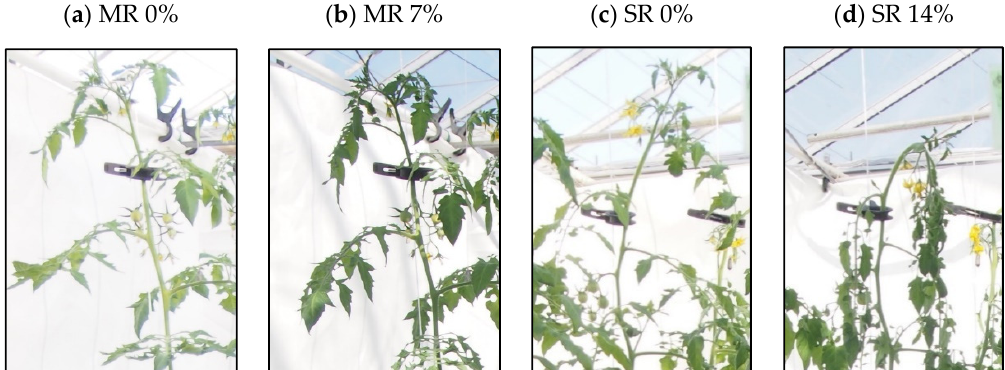
Figure 1. Digital color images of tomato plants captured from the side at three wilting ratios. ( a ) Plant subjected to MR without wilting in the early morning. ( b ) Plant subjected to MR when W was 7%. ( c ) Plant subjected to SR without wilting in the early morning. ( d ) Plant subjected to SR when W was 14%. W: wilting ratio; MR: moderate wilting–full recovery treatment; SR: severe wilting–full recovery treatment.